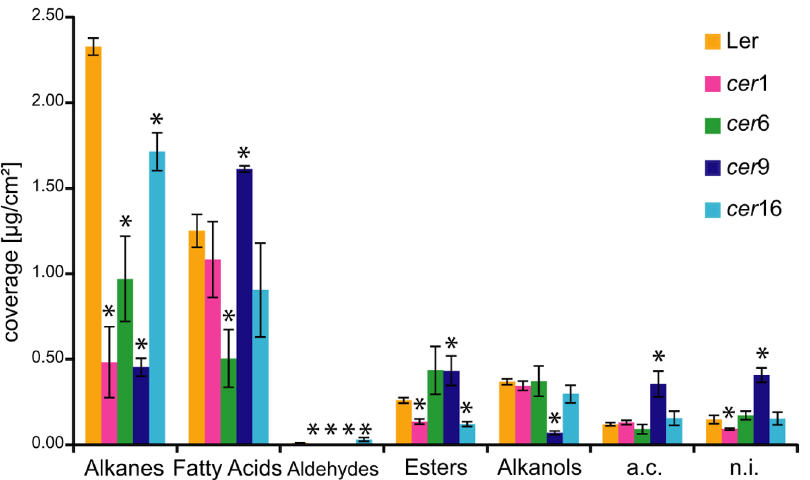
Figure 1. Analyses of cer mutant cuticular waxes. Cuticular wax extracts of five 14-week-old A. thaliana lines ( cer 1, cer 6, cer 9, cer 16, Ler) grown partially under outdoor growth conditions were analysed. The main compound classes were alkanes, fatty acids, wax esters and alkanols ( m g cm 2 2 6 SD; n=3) Abbreviations: a.c. = additional components (combining sterols, triterpenoid-like compounds, C 29 ketone, secondary alkanols and monoglycerides of fatty acids), n.i. = not identified compounds.